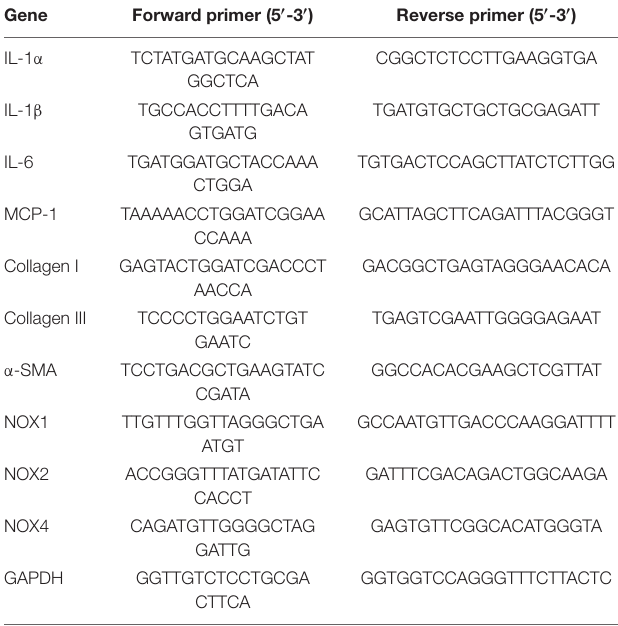
TABLE 1 | Primers used for quantitative real-time PCR analysis.